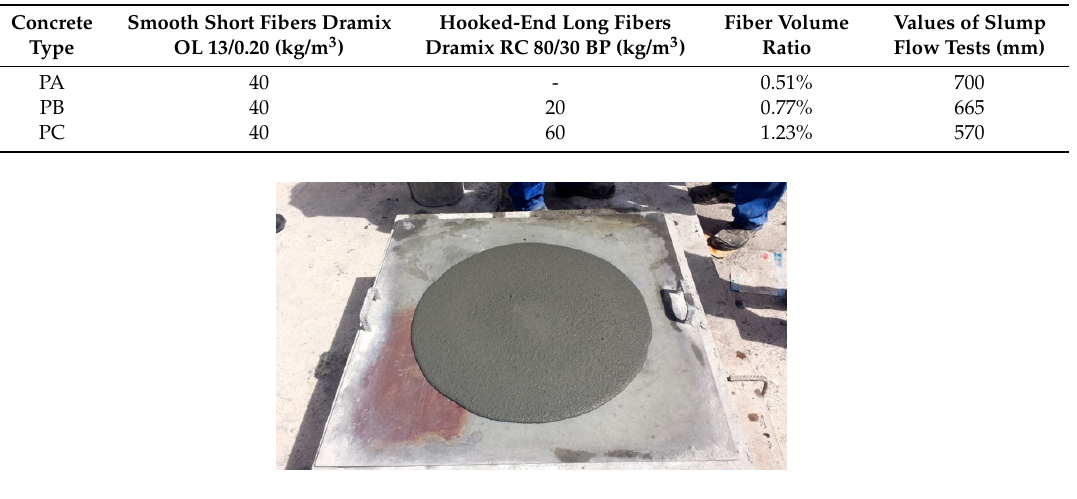
Table 2. Properties of concretes at an age around seven months.